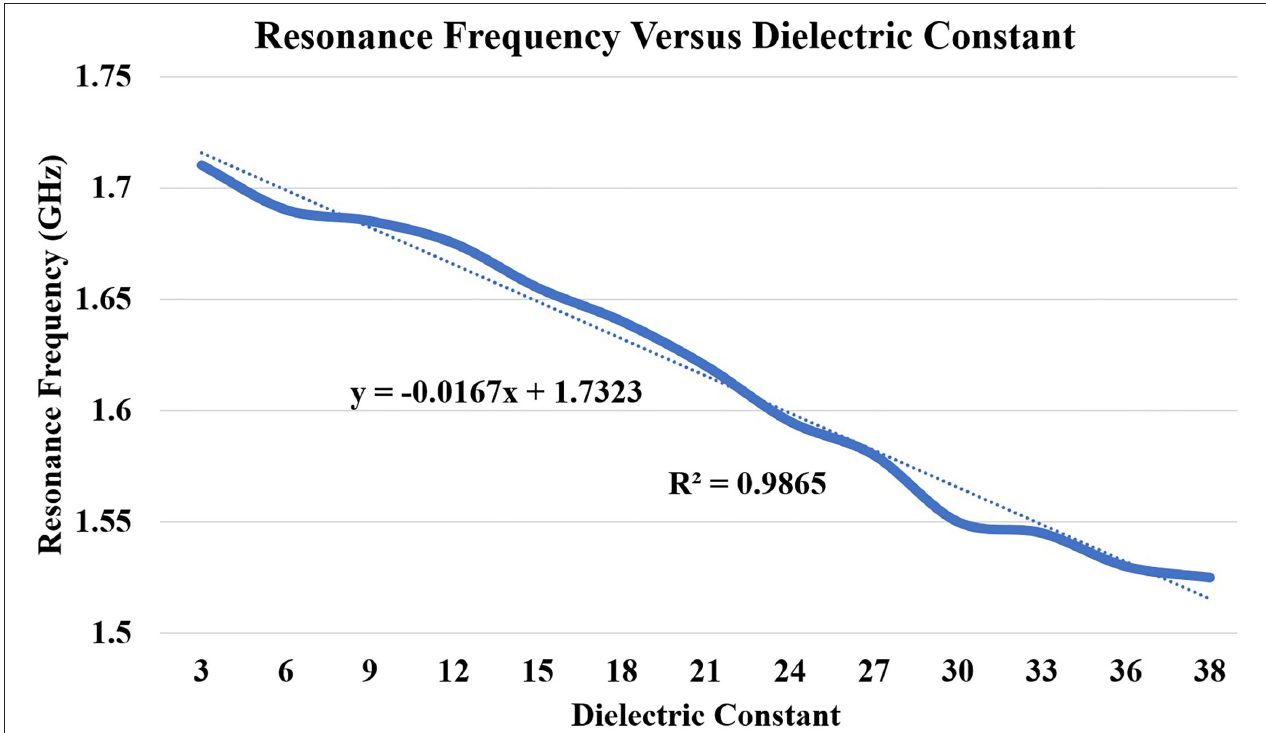
FIGURE 13 | Correlation between dielectric constant ( ε r 3 to 38) and principal resonant frequency shift (based on S 11 ). The dotted lines present along with correlated data are the trend